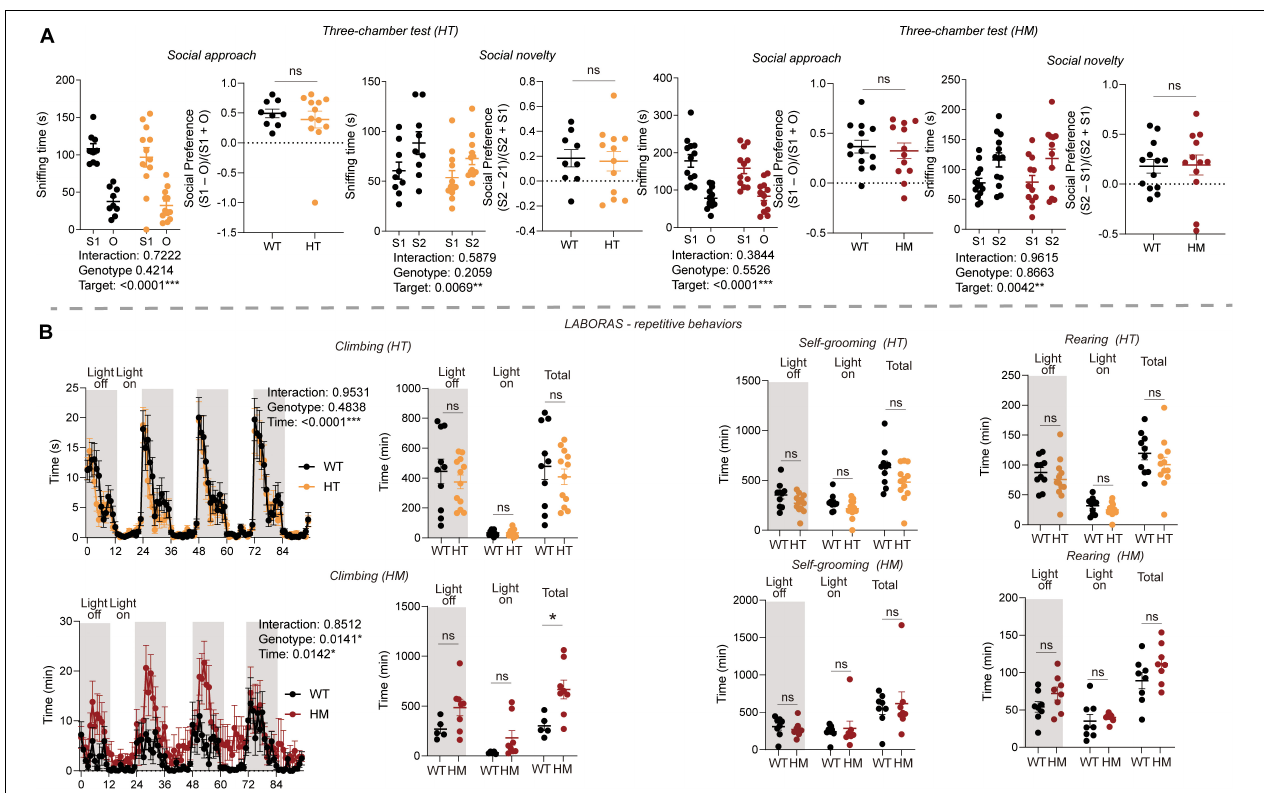
FIGURE 2 | Slc6a20a deficiency in mice moderately enhances repetitive behavior without affecting social behavior. (A) Normal levels of social approach and social novelty recognition are seen in Slc6a20a + / − and Slc6a20a − / − mice (3–6 months) in the three-chamber test, as shown by the time spent exploring/sniffing a